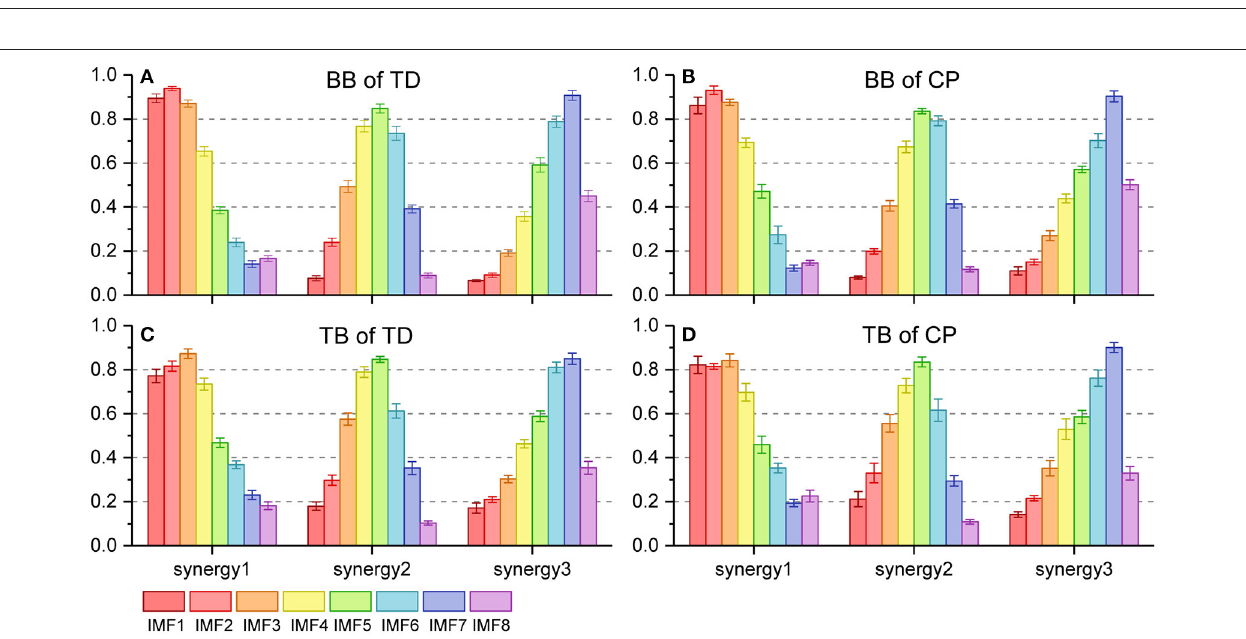
FIGURE 6 | Oscillation synergies extracted from 8 sEMG IMFs of BB and TB during one crawling cycle in two groups. (A) BB of TD group; (B) BB of CP group; (C) TB of TD group; (D) TB of CP group.